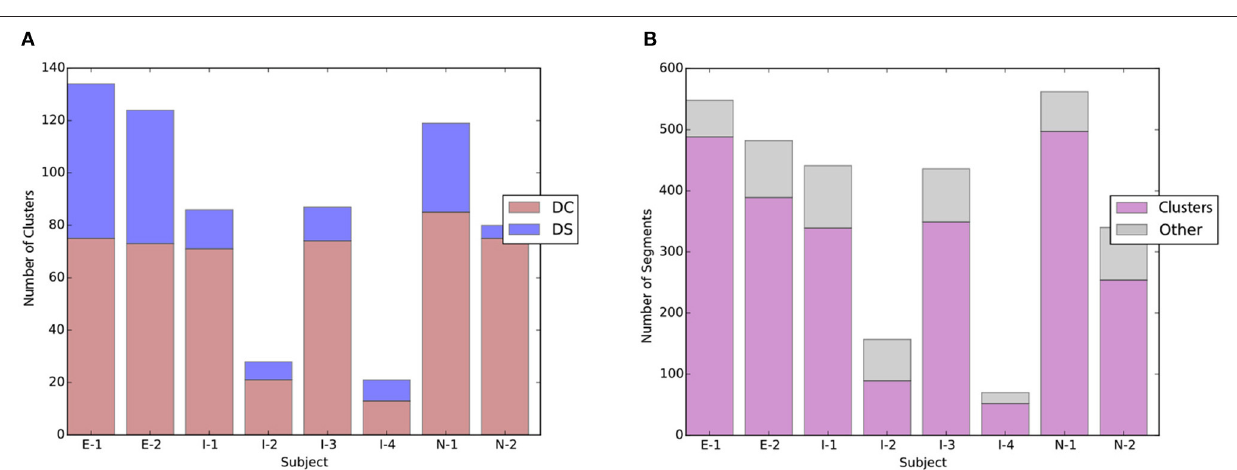
Frontiers in Psychology | www.frontiersin.org